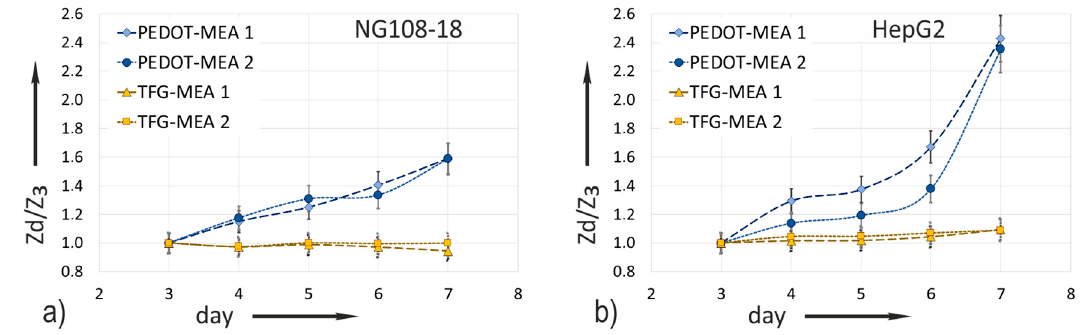
Figure 7. Impedance increase ratio calculated using Equation (1) for TFG-MEAs and PEDOT-MEAs (based on mean values of all electrodes measured at 1 kHz): ( a ) NG108-15 cell culture; ( b ) HepG2 cell culture.